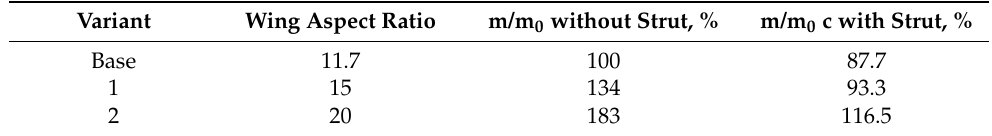
Figure 17. Ultimate bending and torsion moments and shearing forces for three variants of wing aspect ratio. Table 4. Weight characteristics of wing, with and without strut, compared to base variant without